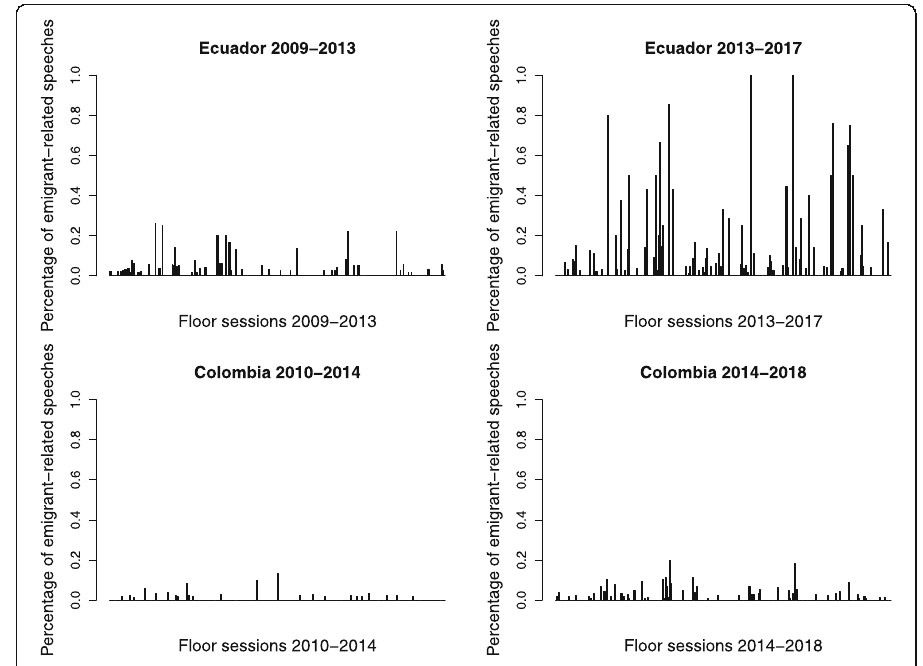
Fig. 2 Percentage of speeches related to emigration in plenary sessions. Author ’ s